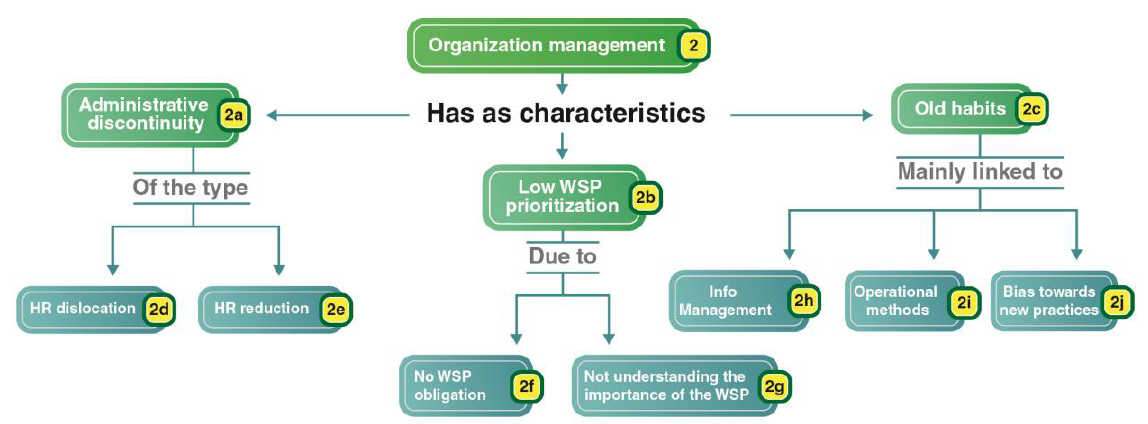
Figure 6. Aspects of an organization’s management that impact the water safety plan (WSP) imple- mentation (drafted by the author). Note: HR = human resources.